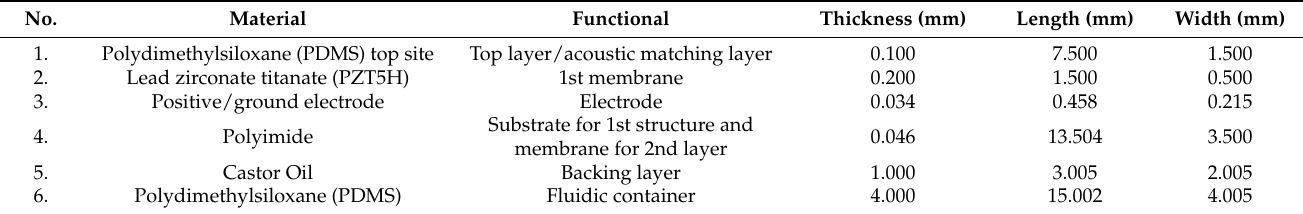
Table 3. Parameters of the final PMUT with double cavities and fluidic backing